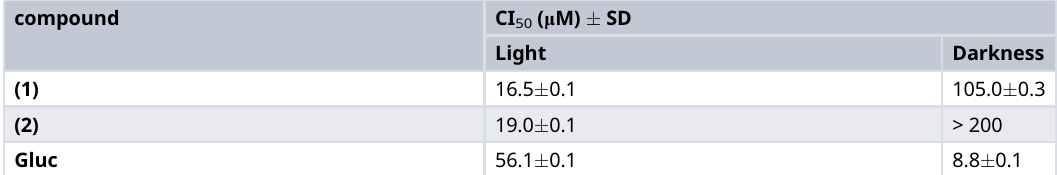
Table 4. IC 50 values for compounds TBrPP, TBrPP-Sn (IV) and positive control against L. panamensis, 24-hour incubation treatments.